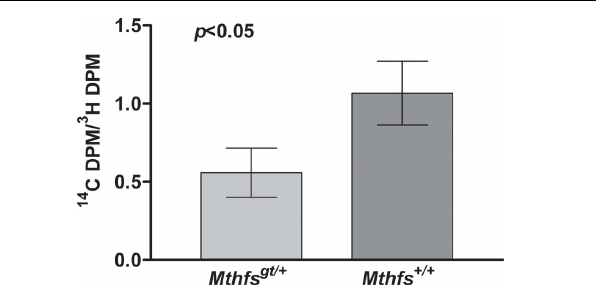
FIGURE 5 | Mthfs gt/ + mouse embryonic fibroblasts (MEFs) exhibit less efficient de novo purine biosynthesis. MEFs were isolated as described in Section “Materials and methods” and cultured in the presence of [ 3 H]-hypoxanthine and [ 14 C]-formate. [ 3 H]-Hypoxanthine is converted to purines via the folate-independent salvage pathway, whereas [ 14 C]-formate is incorporated into purines via the de novo pathway.The 14 C/ 3 H DPM ratio was determined in nuclear DNA from two independent cell lines for both Mthfs + / + and Mthfs gt/ + genotypes.The 14 C and 3 H content (dpm) in resulting fractions were quantified on a Beckman Coulter LS6500 Scintillation Counter.Variation is expressed as standard deviation of the mean (two cell lines per genotype), data were analysed using a student’s t -test.